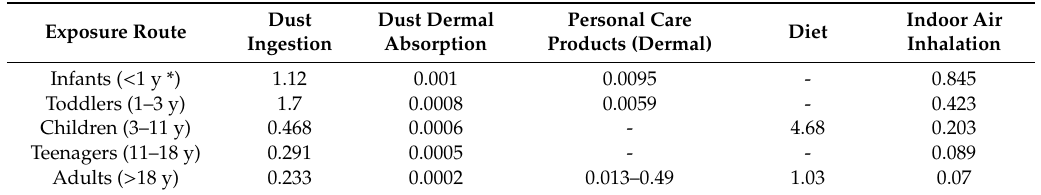
Table 2. Human exposure doses to total phthalates for the US population through various pathways ( µ g / kg bw / d). Dust Exposure Route